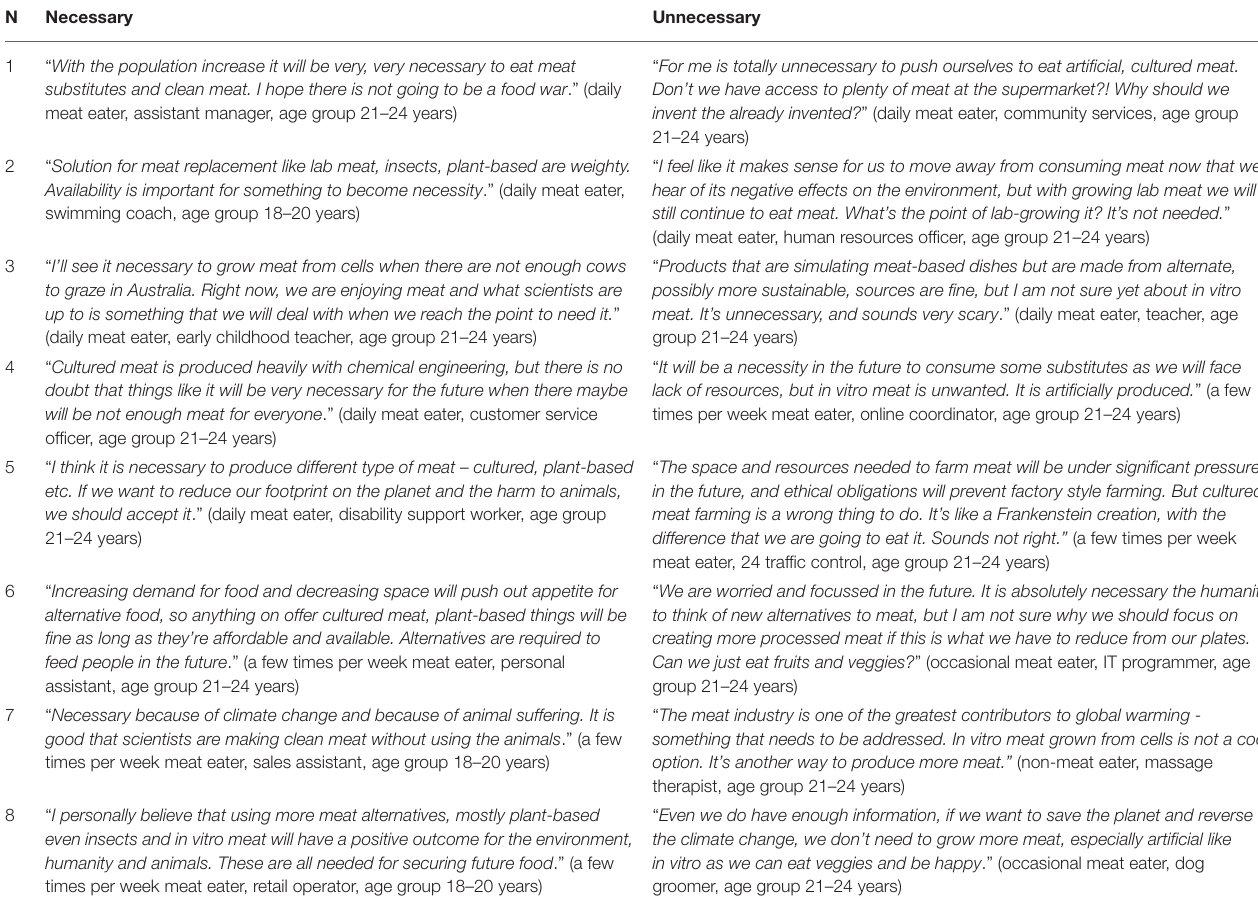
TABLE 4 | Sydney Gen Z’s perceptions about need for cultured